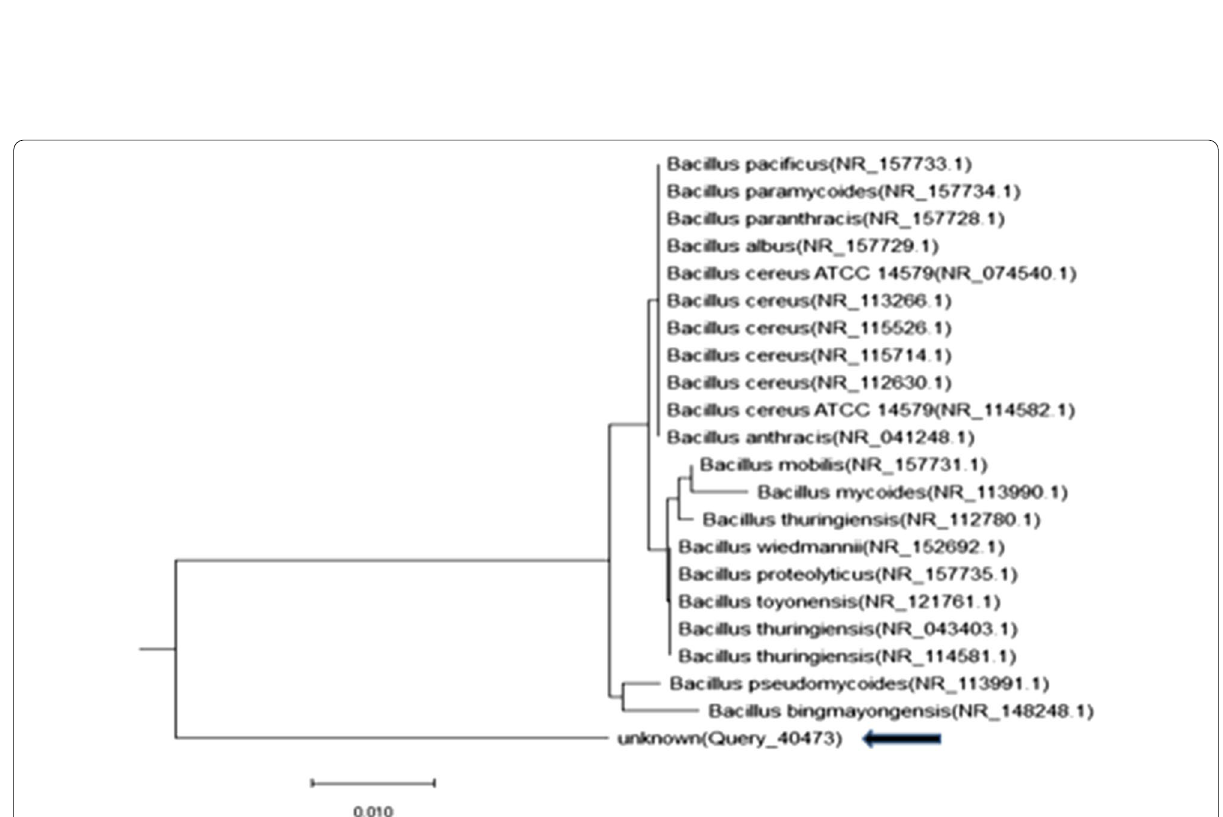
Fig. 2 Phylogenetic dendrogram obtained by distance matrix analysis of 16S rRNA sequences, showing the position of (B1) Bacillus wiedmannii among phylogenetic neighbors